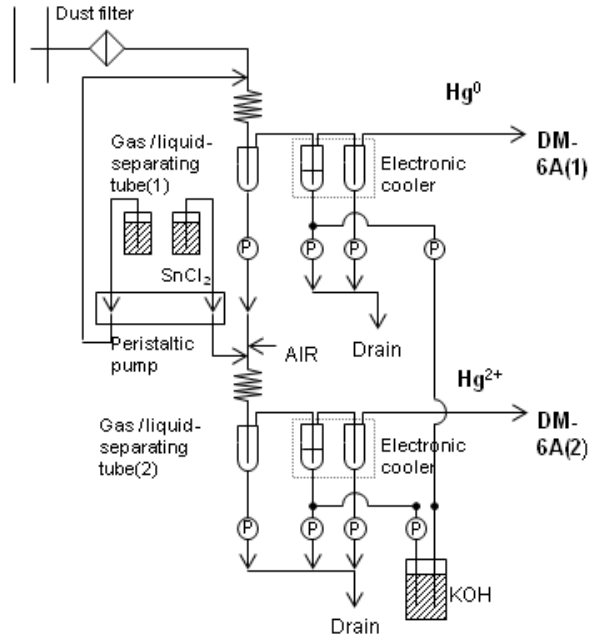
Fig. 1. The pretreatment section of the speciation Figure 1. The pretreatment section of the speciation CEM.